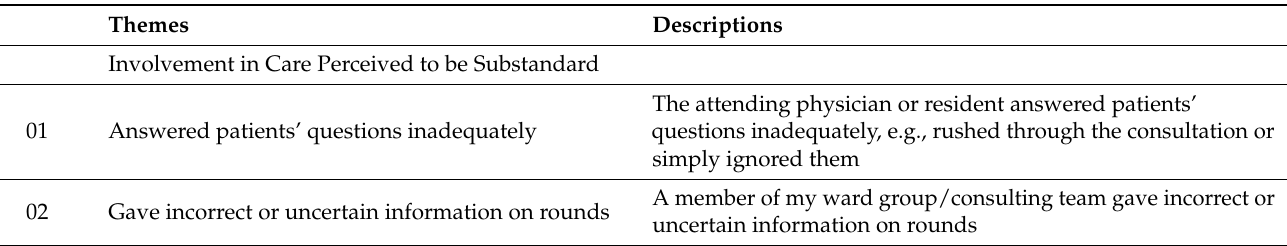
Table 1. Themes and descriptions of the 30